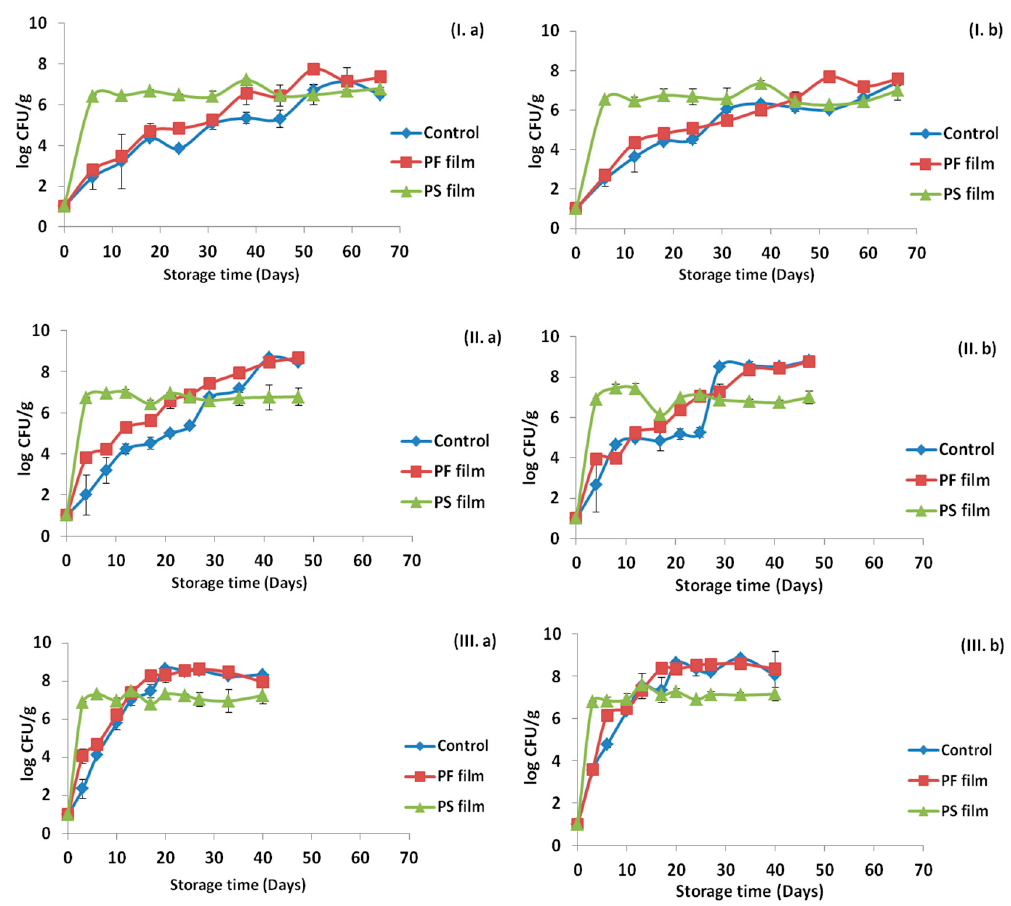
Figure 2. Changes in population levels of: ( a ) lactic acid bacteria; and ( b ) Total Viable Counts on ham slices with PS after HPP treatment during storage at: 4 °C ( I ); 8 °C ( II ); and 12 °C ( III ). Samples without edible films (controls) or with PF were also studied.